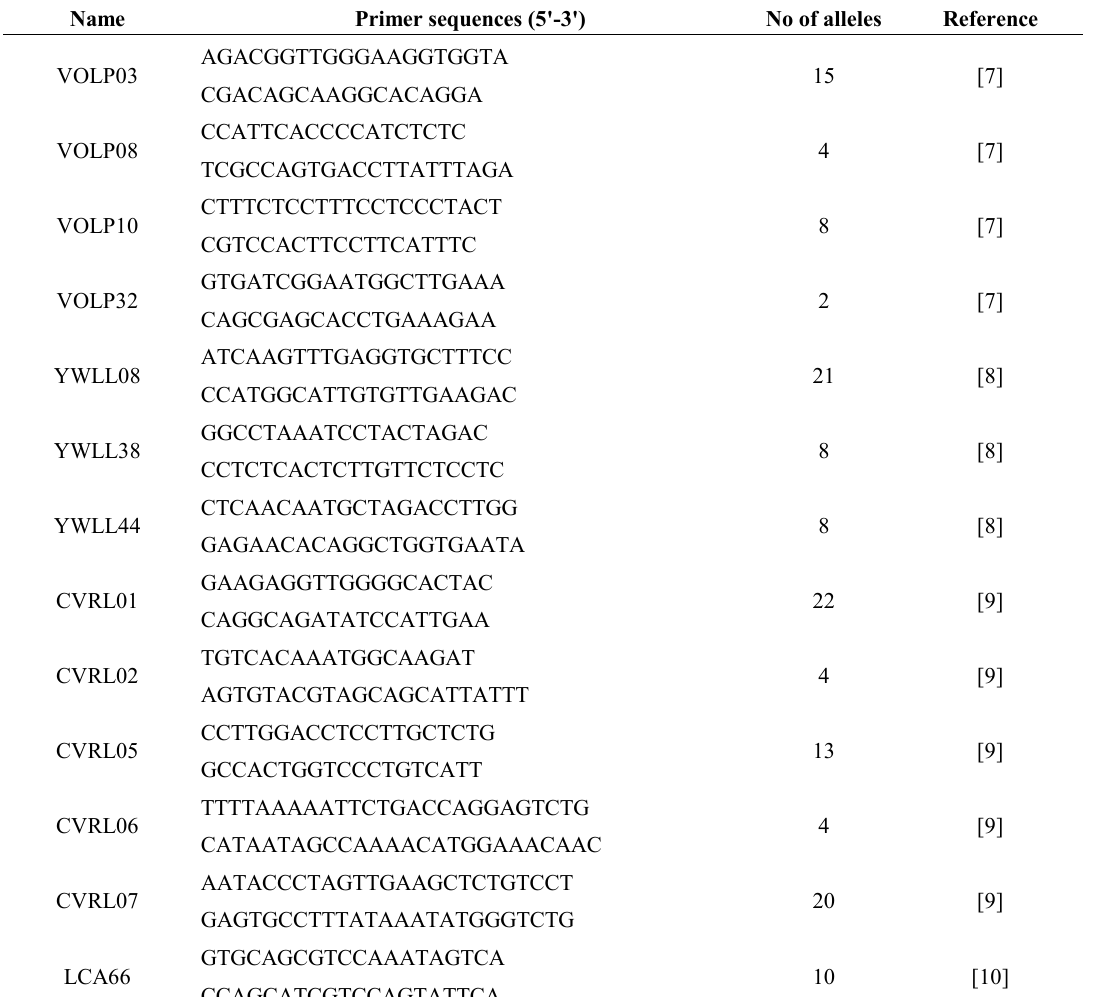
Table 1. Microsatellite polymorphism: the name, primer sequence, number of alleles and reference for the 13 microsatellite markers